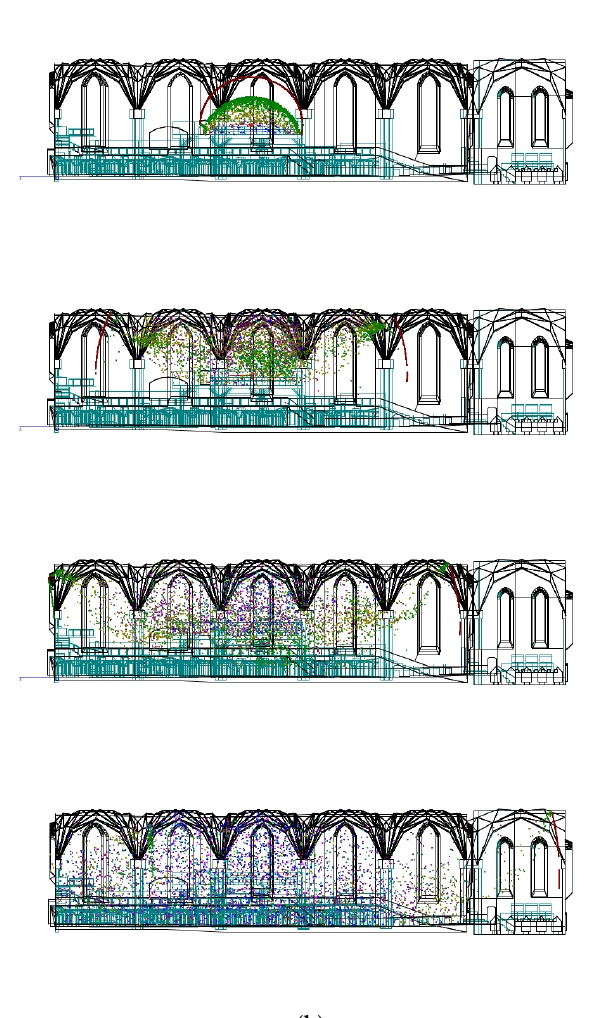
Figure 12. Images illustrating the dispersion of acoustic energy, as approximated by an acoustic particle model, over time. Subfigure ( a ) shows the progression when the source is located in the choir, and subfigure ( b ) shows when the source is located in the gallery. From top to bottom, the pictures show snapshots at 20 ms, 60 ms, 80 ms, and 120